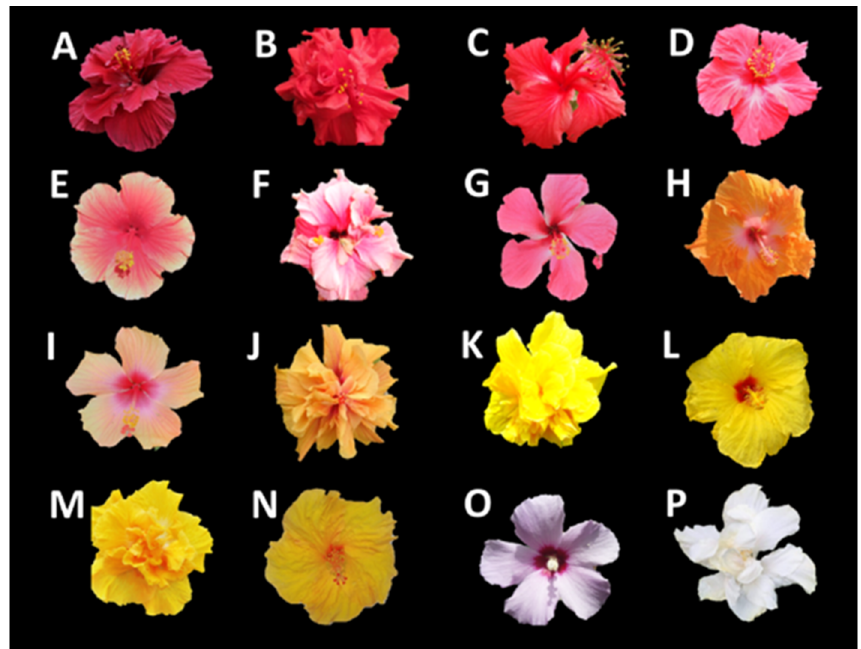
Figure 1. Flowers of 16 H. rosa ‐ sinensis cultivars collected from the natural population of the CENIVAM experimental botanical garden, Universidad Industrial de Santander, Bucaramanga, Co ‐ lombia. ( A – D ) Red. ( E – G ) Pink. ( H – J ) Orange. ( K – N ) Yellow. ( O ) Lilac. ( P )